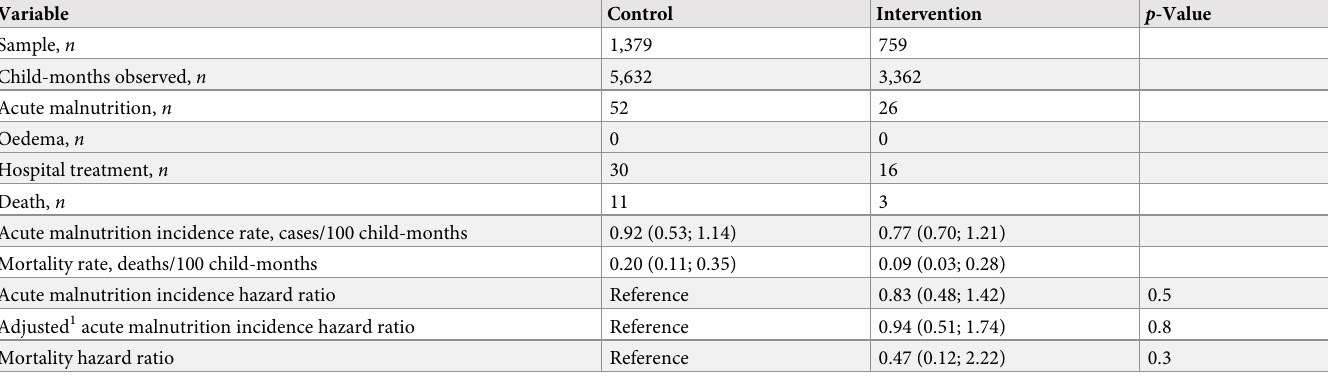
Table 3. Effect of the intervention on time to first episode of acute malnutrition or death. Variable